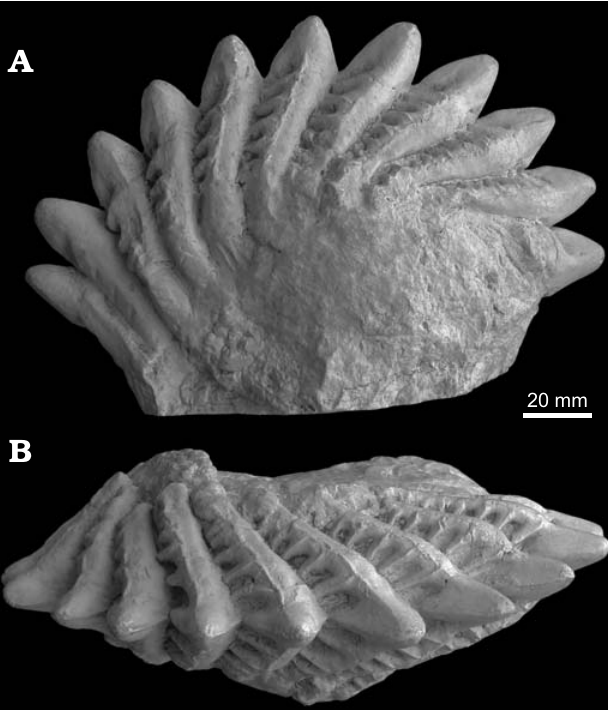
Fig. 10. Cast of a symphyseal tooth whorl (NHMUK P.9673) of the euge- neodontiform shark “ Campodus variabilis ” sensu Eastman (1902–1903) from the Coal Measures (Pennsyl vanian) of Cedar Creek, Nebraska, USA. A . Lateral view. B . Oral